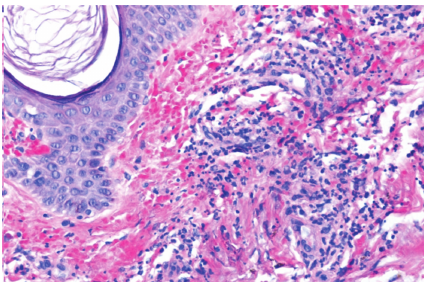
Figure 1: Leukocytoclastic vasculitis: predominantly lymphocytic mixed inflammatory infiltrate involving small vessels in the dermis (hematoxylin-eosin, original magnification × 200).